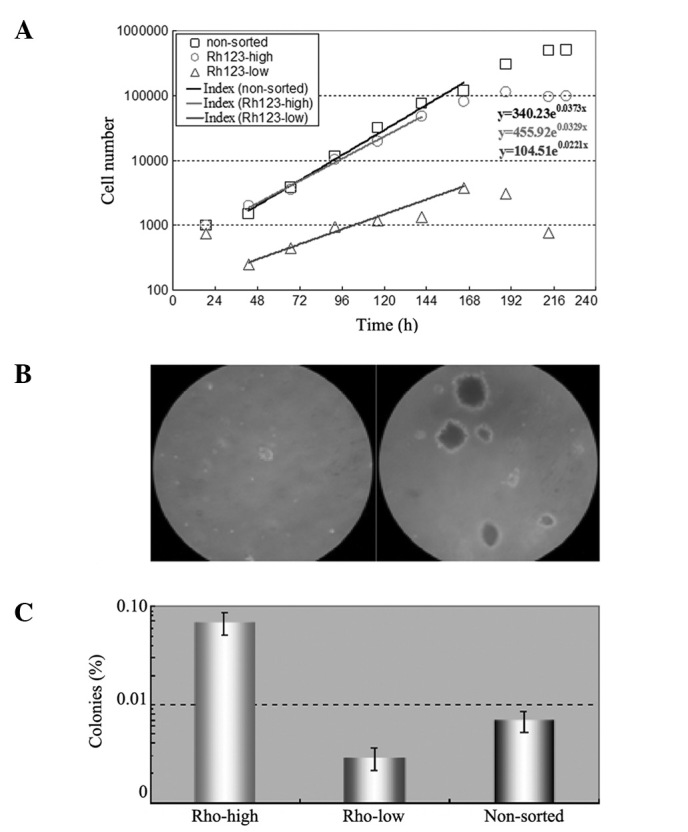
Growth curve and clone formation of Rh123high, Rh123low and unsorted 786-O cells. (A) Growth curve of Rh123high, Rh123low and unsorted 786-O cells. (B) Sorted colonies of Rh123low cells (Left) and Rh123high cells (Right) in soft agar. (C) Colony formation efficiency of Rh123high, Rh123low and unsorted 786-O cells. Rh123, rhodamine 123.